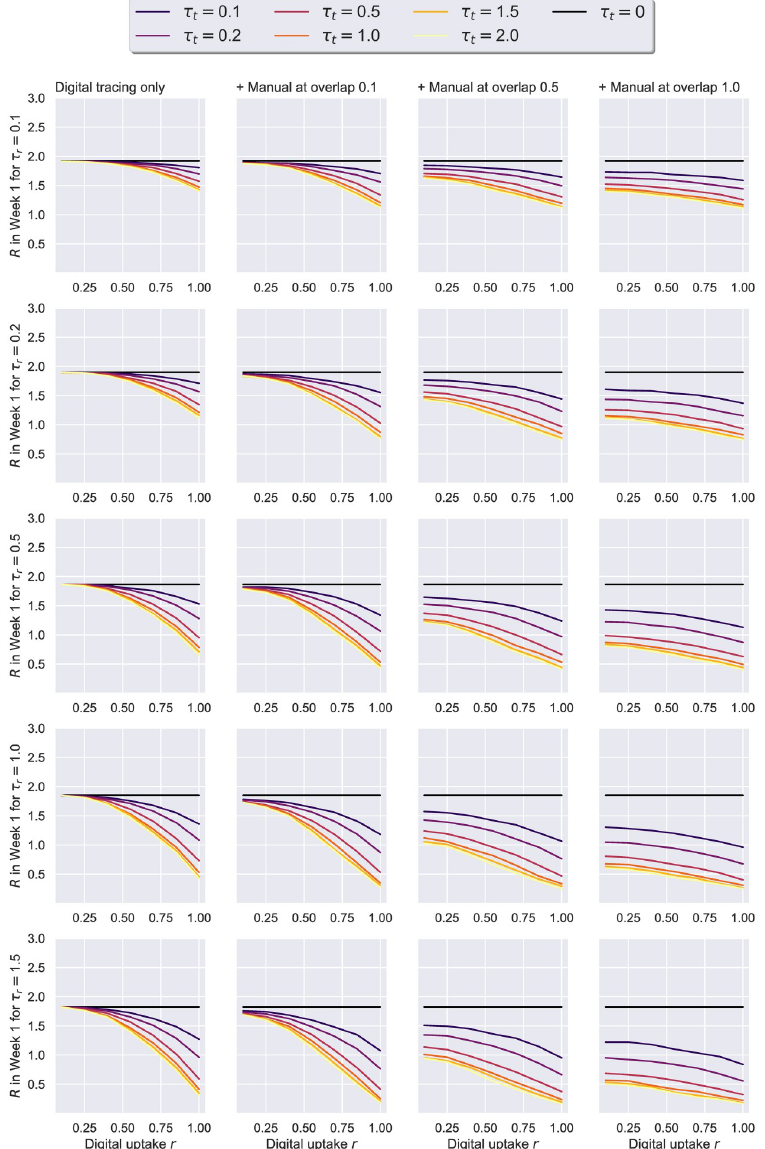
Fig 16. Social evolution—Uptake rate r against the effective reproduction number R . Suppression represents the difference to no tracing, i.e. τ = 0. The results here correspond to the data-driven Social Evolution network, p t η = .001. On the left, we have a scenario in which only digital tracing was conducted, whereas the next columns represent simulations with a combination of digital tracing on a second network, and manual tracing over a third network with various overlaps: 0.1, 0.55, 1. The case with no contact tracing ( τ t = 0) is colored in black.